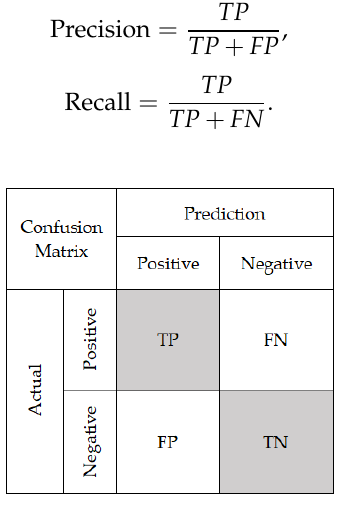
Figure 11. Confusion matrix.